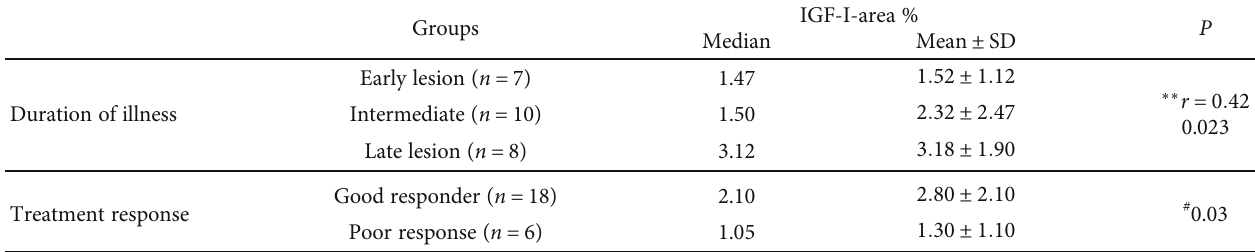
Table 2: Area of expression of insulin-like growth factor (IGF)-I in the lesions of cutaneous leishmaniasis patients according to the duration of illness and response to